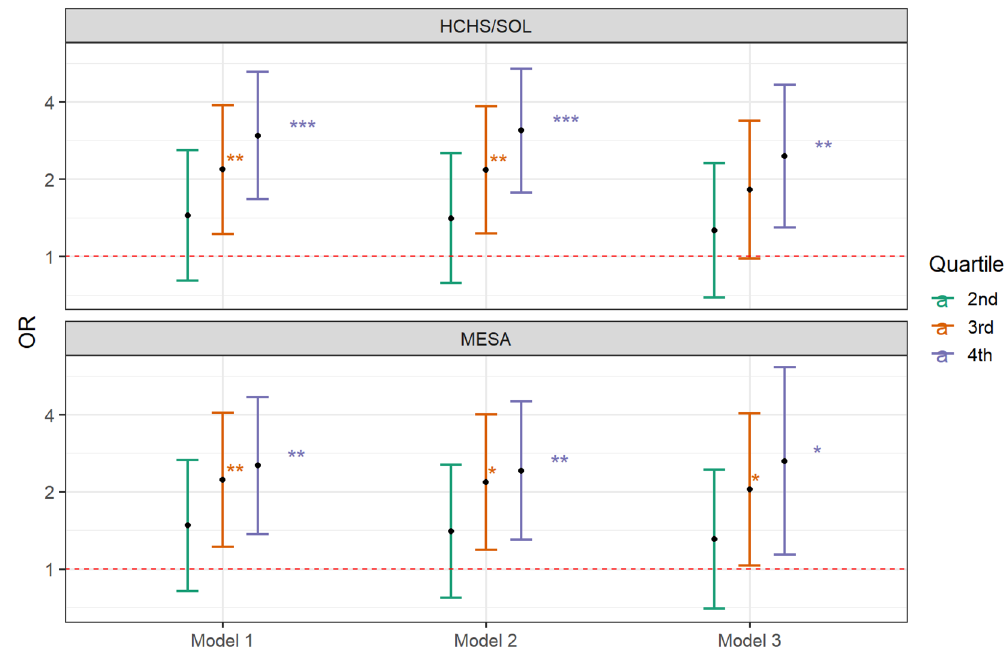
Figure 4. Odds ratio of metabolite index for OSA by quartiles in HCHS/SOL and MESA. *indicates p < 0.05. **indicates p < 0.01. ***indicates p < 0.001 In HCHS/SOL: Model 1 adjusted for age, gender, center, background, and BMI. Model 2 adjusted for age, gender, center, background, BMI, alcohol use, smoking status, physical activity and diet (AHEI 2010). Model 3 adjusted for age, gender, center, background, BMI, alcohol use, smoking status, physical activity, diet, T2DM, hypertension, fasting glucose, fasting insulin, HOMA IR, HDL, LDL, total cholesterol, triglycerides, systolic blood pressure and diastolic blood pressure. In MESA: Model 1 adjusted for age, gender, BMI, study site (site WFU and UCLA are combined due to low cell count), and race. Model 2 adjusted for age, gender, BMI, study site, race, alcohol use and smoking status. Model 3 adjusted for age, gender, BMI, study site, race, alcohol use, smoking status, hypertension indicator, fasting glucose, HDL, LDL, cholesterol, triglycerides, systolic blood pressure and diastolic blood